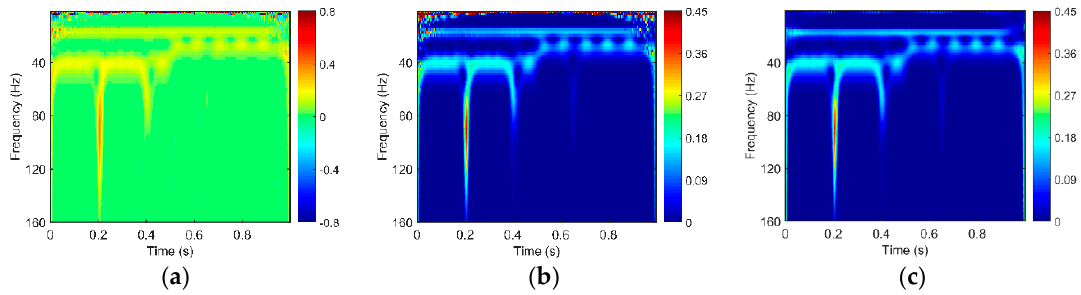
Figure 4. Instantaneous energy sections obtained based on: ( a ) the original TK; ( b ) the absolute value of the original TK; and ( c ) the FWEO.